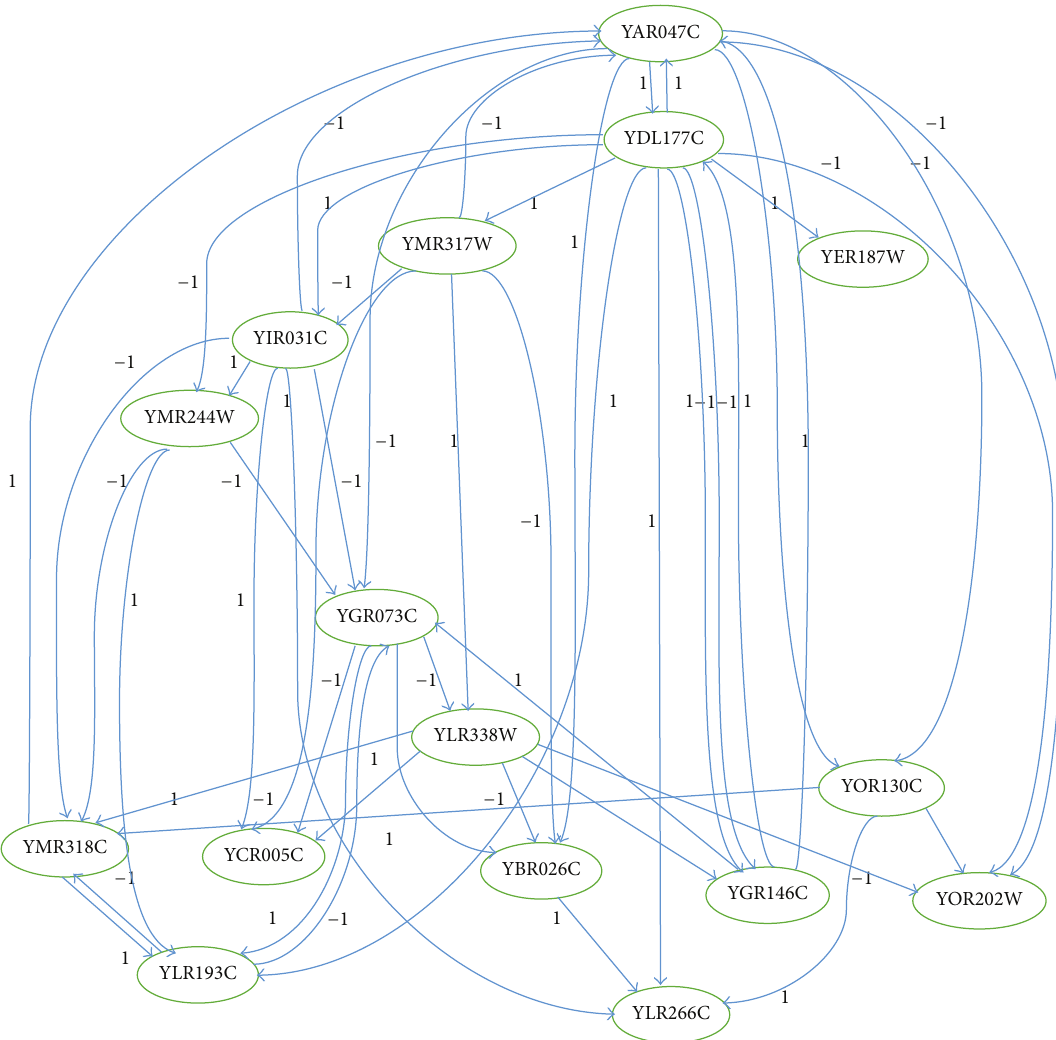
Figure 3: Inferred GRN of yeast cell cycle genes dataset with 16 genes and 50 direct links showing upregulation and downregulation. The notation ( − 1) is used to indicate downregulation and (1) to show upregulation between